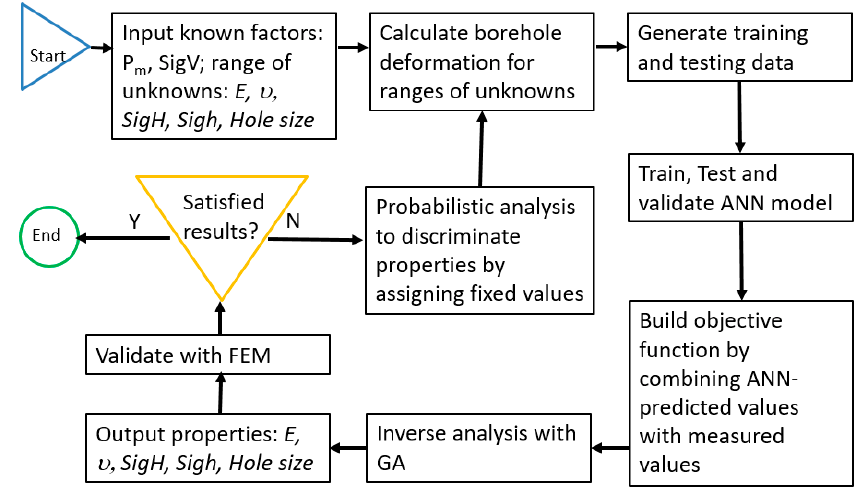
Figure 2. Workflow of the probabilistic recapitulation-genetic algorithm-artificial neural network (PR-GA-ANN) method.